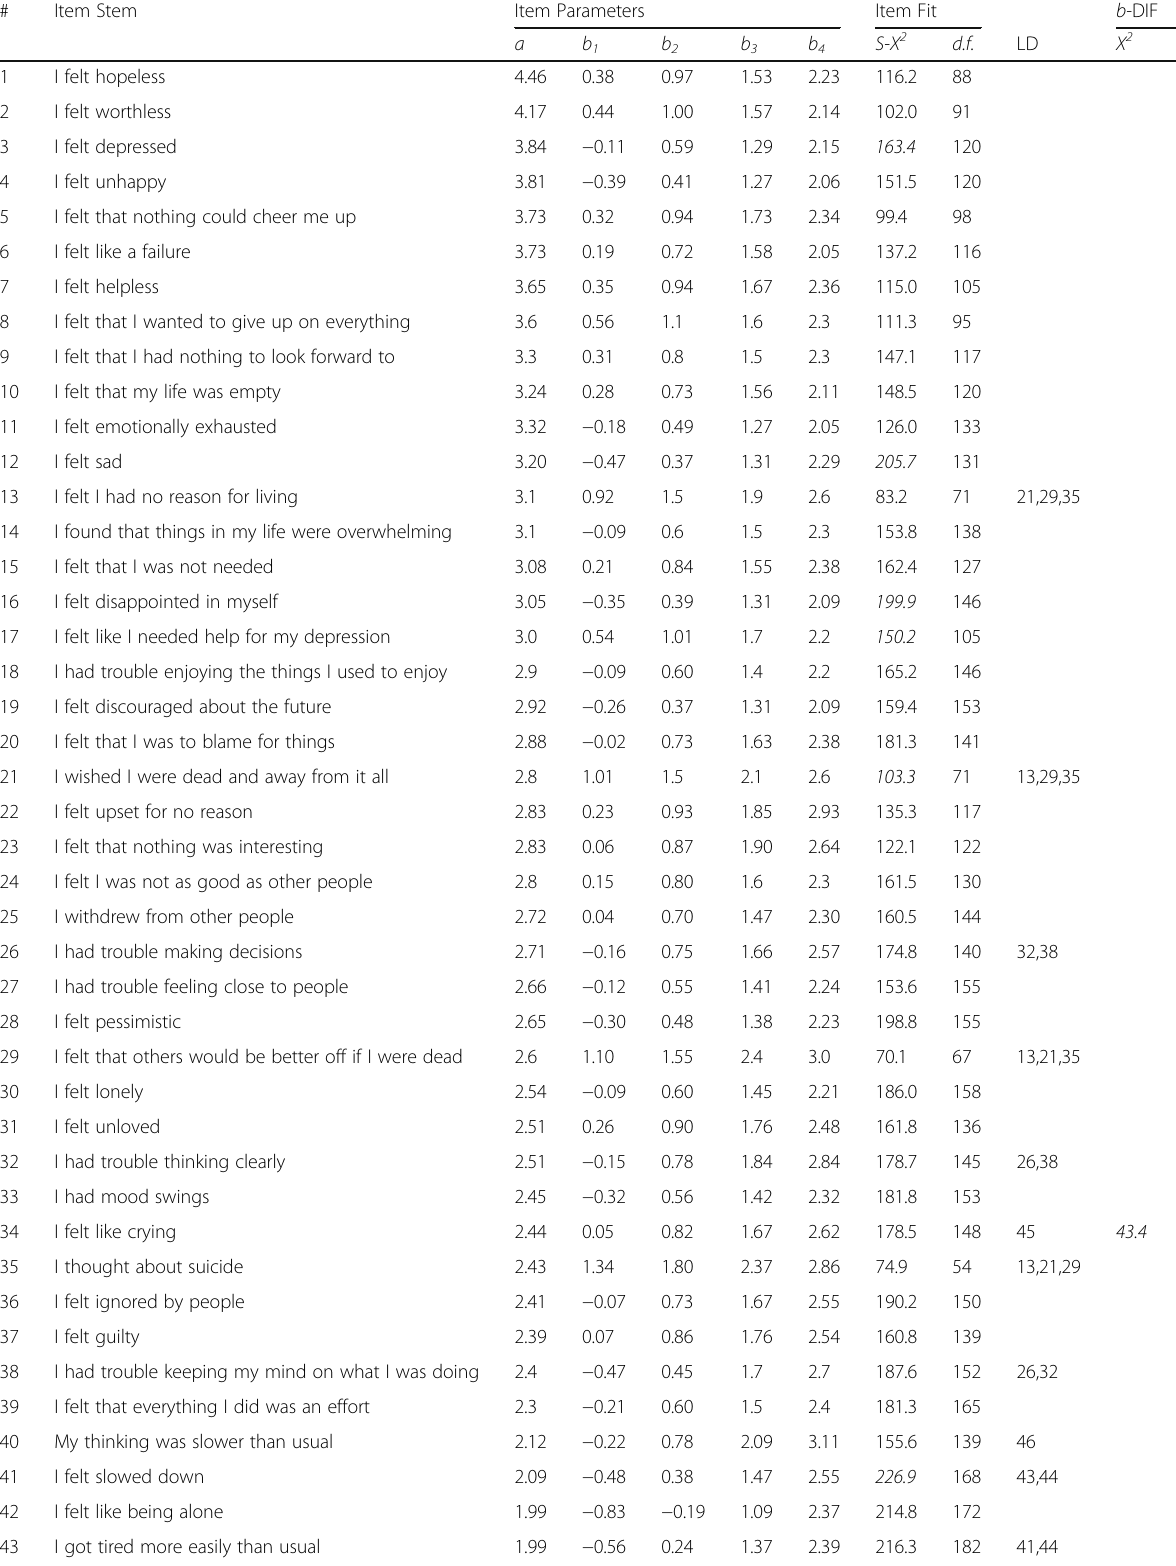
Table 2 Item parameters, fit statistics, local dependence, and DIF results for the 51 PROMIS® depression items # Item Stem Item